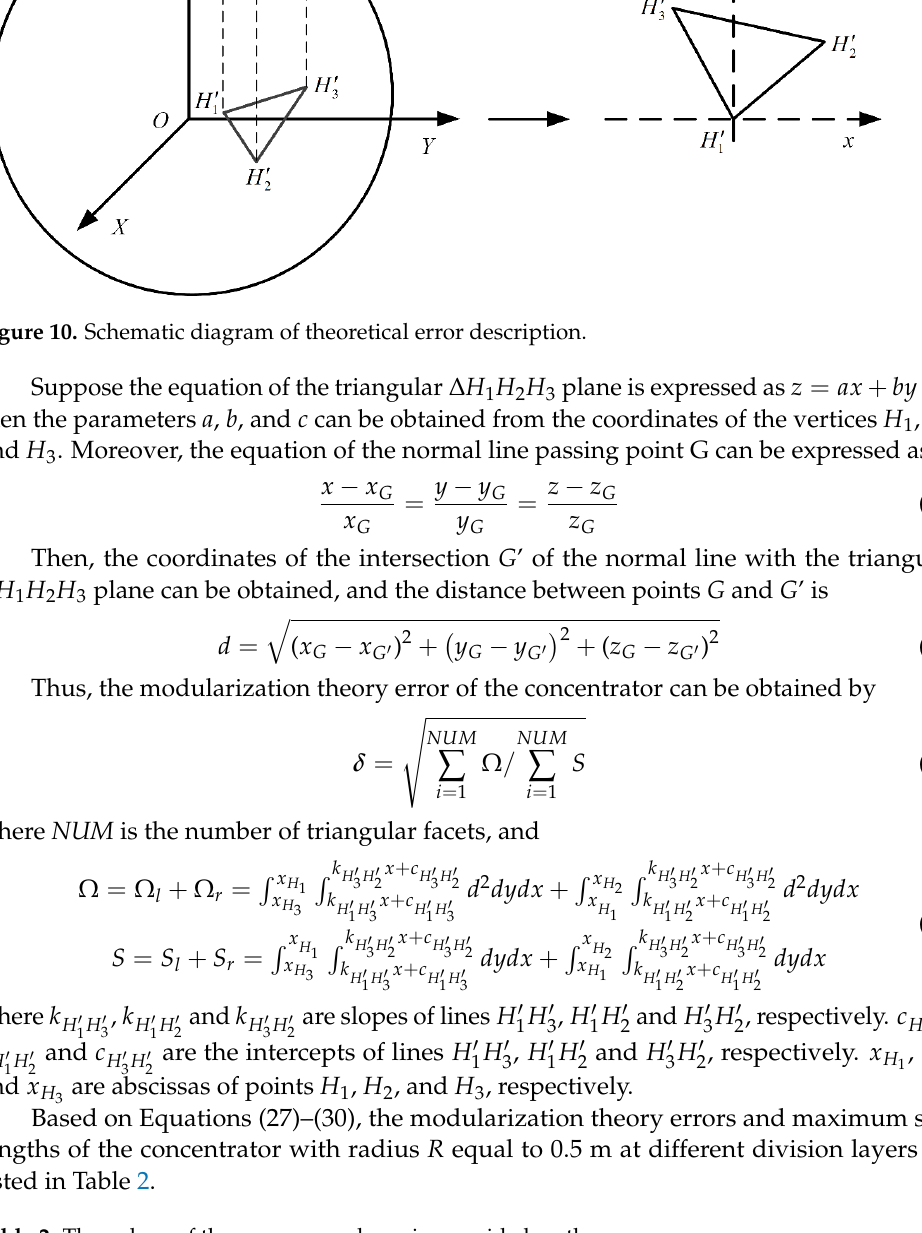
Table 2. The values of theory error and maximum side